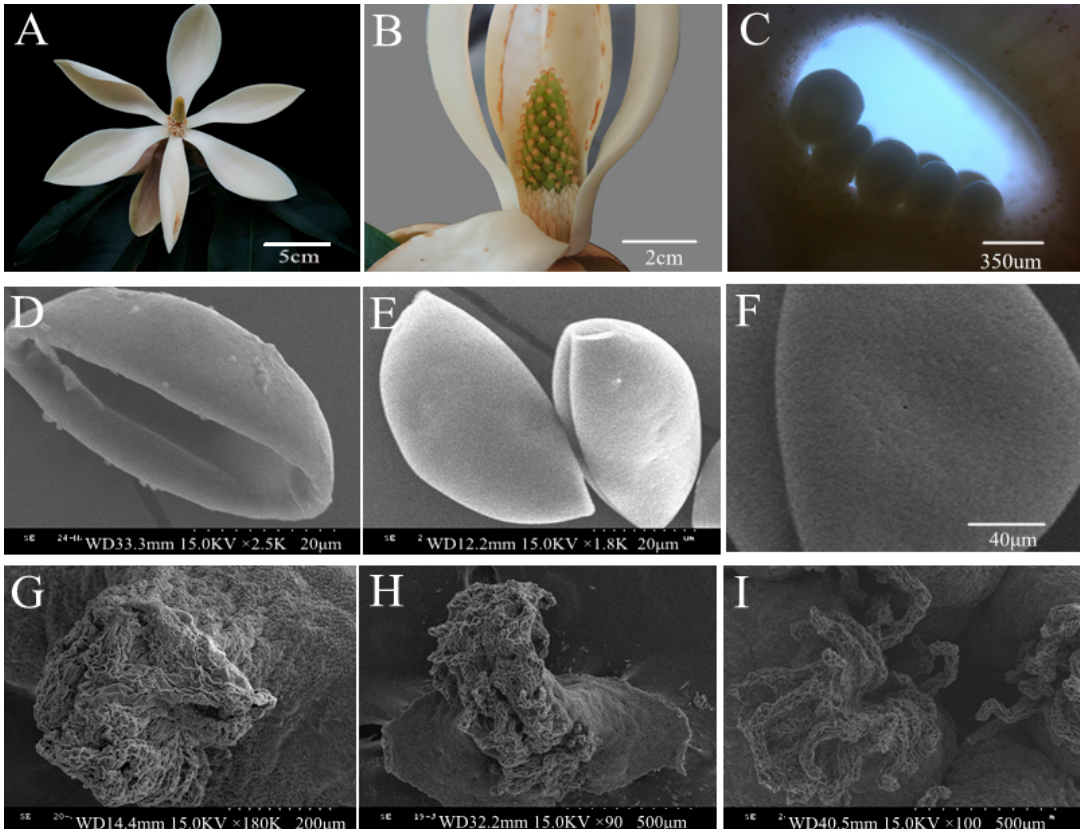
Figure 2. Flower structure and male and female organs of M. conifera flower. Note: ( A ) Full bloom; ( B ) Inner configuration of the flower; ( C ) Double row of ovules in the carpel; ( D , E ) Boat-shaped pollen grain; ( F ) Porous texture of the pollen wall; ( G – I ) Different stigma types.